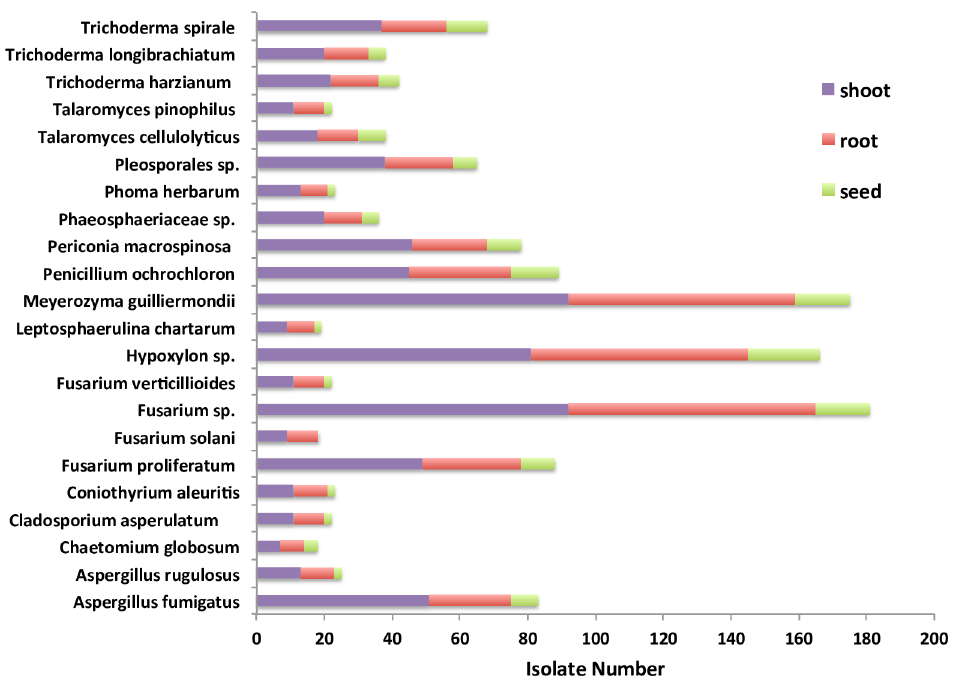
Fig 3. The distribution of endophytic fungi at species level. The data were analyzed among different tissues of switchgrass grown on the coal-mining site.